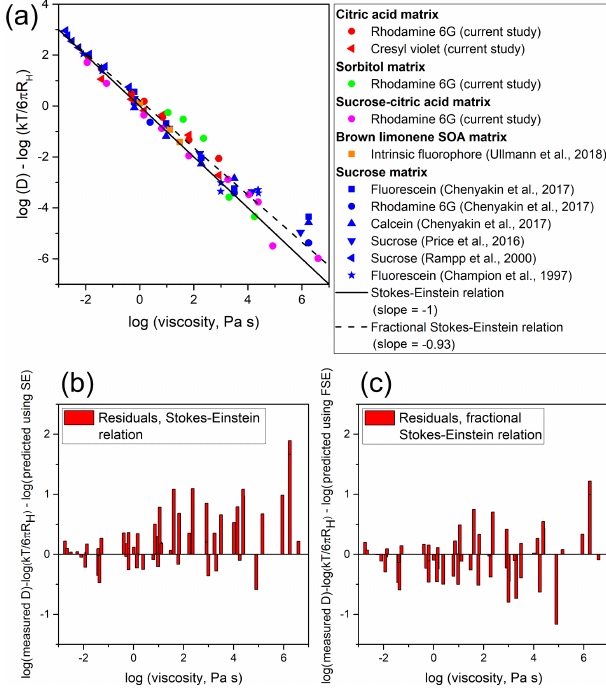
Figure 3. (a) Plot of log (D) − log (kT/ 6 πR H ) as a function of log ( η ) for experimental diffusion coefficients reported in this work and literature data. Indicated in the legend are the diffus- ing organic molecules studied and the corresponding matrices. T corresponds to the experimental temperature of each diffusion coefficient and R H corresponds to the radius of each diffusing species (Sect. S2 and Table S6). The symbols represent experi- mental data points. The solid line represents the relationship be- tween log (D) − log (kT/ 6 πR H ) and log ( η ) predicted by the Stokes– Einstein relation, while the dashed line represents the relationship between log (D) − log (kT/ 6 πR H ) and log ( η ) predicted by a frac- tional Stokes–Einstein relation with a slope of − 0 . 93 and crossover viscosity of 10 − 3 Pas. Panels (b) and (c) are plots of the differ- ences (i.e., residuals) between experimental and predicted values of log (D) − log (kT/ 6 πR H ) using the Stokes–Einstein relation and the fractional Stokes–Einstein relation, respectively. The sum of squared residuals for the Stokes–Einstein relation is 19.7 and the sum of squared residuals for the fractional Stokes–Einstein relation is